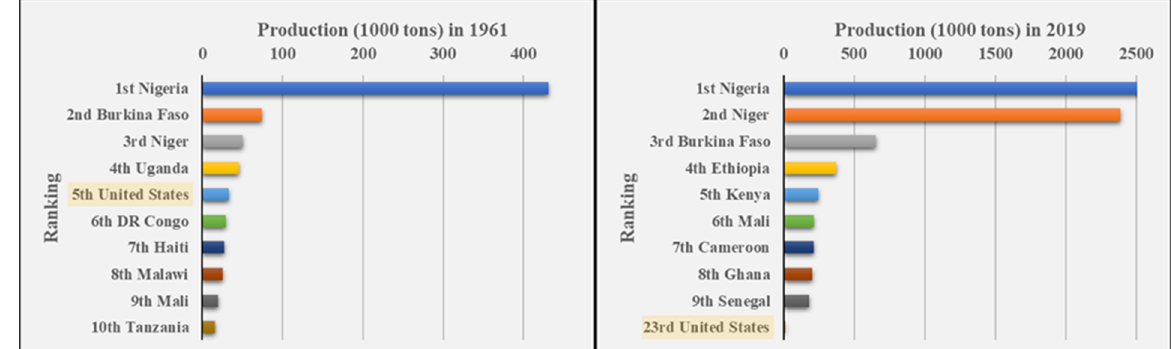
Figure 2. Production ranking of cowpea-producing countries in 1961 and 2019. Note that Nigeria produced 3.6 million tons of cowpea in 2019; data were limited to 2.5 million tons to allow the much lower production of other countries to be reflected in the figure. Data were adapted from Food and Agriculture Organization (FAO) database in August 2021.